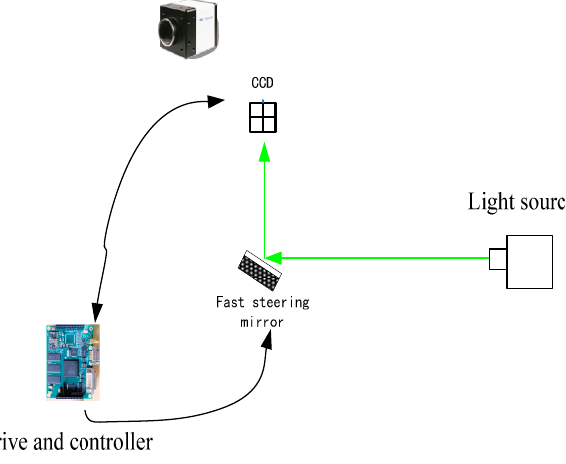
Figure 1. Configuration of the charge couple device (CCD) control system.